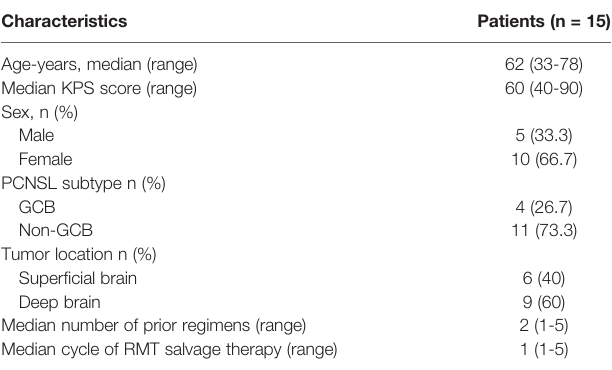
TABLE 1 | Baseline characteristics of the relapsed/refractory PCNSL patients.